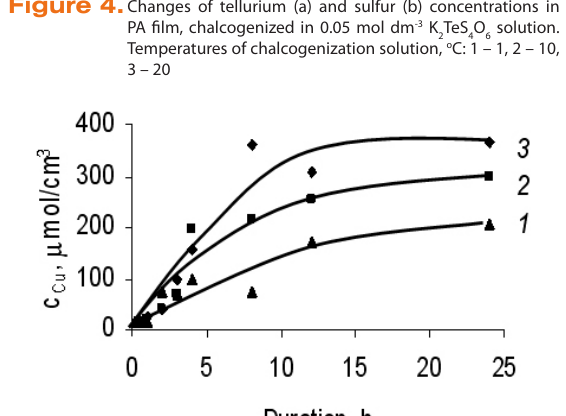
Figure 5. Changes of copper concentration in PA film chalcogenized